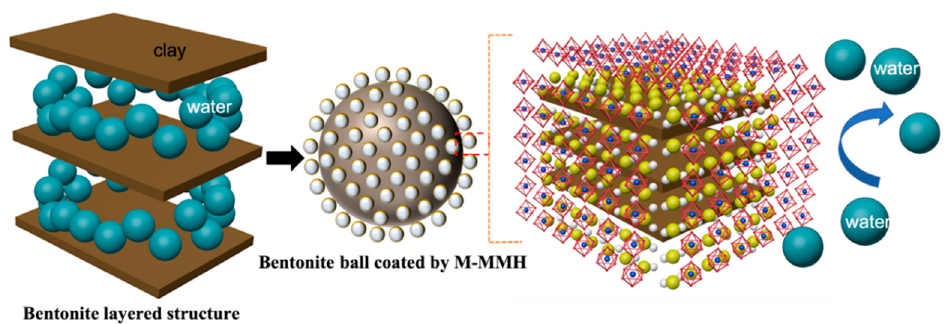
Figure 14. Crystal structure of M-MMH.